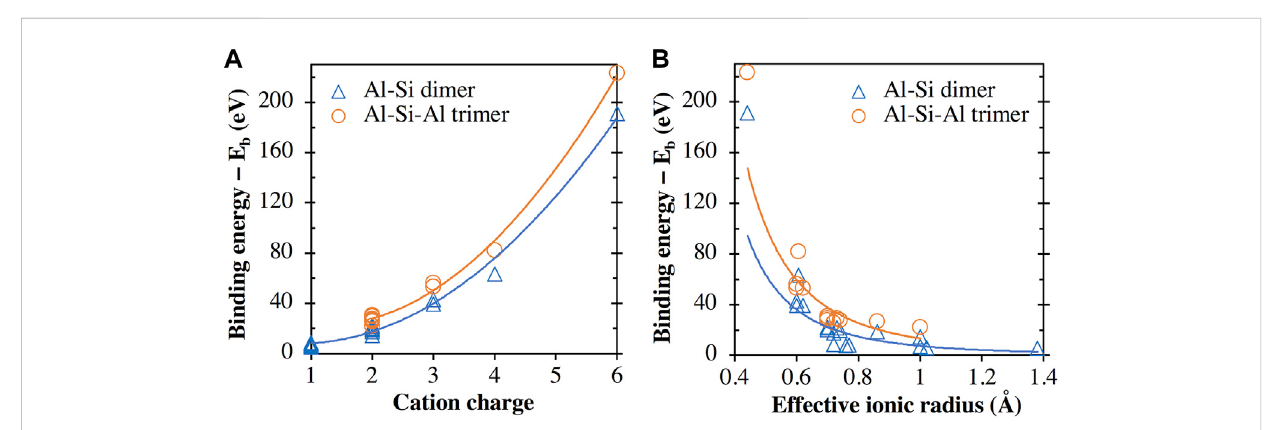
FIGURE 8 Comparison ofbindingenergies ofall themetalcations(including allthemetal cation+OH clusters, e.g.,[Ca(OH)] + )with thealuminosilicatedimer/ trimer and (A) the cation/cluster charge (B) the cation effective ionic radius. In the case of cation + OH clusters (e.g., [Ca(OH)] + ), the effective ionic radius of the corresponding cation (i.e., Ca 2+ ) is used. The lines are given to guide the eye.